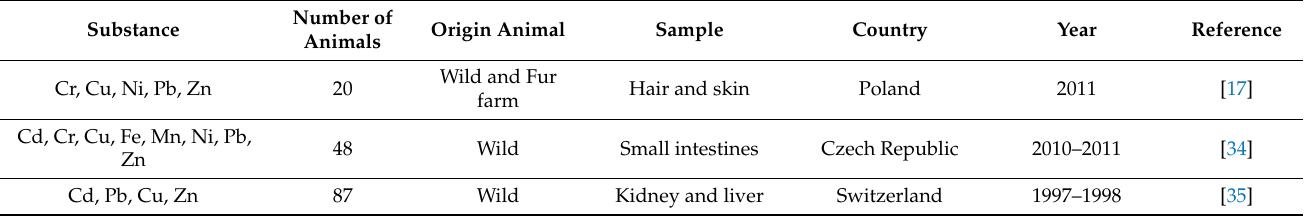
Table 1. Review of articles that evaluated environmental contaminates in red fox ( Vulpes vulpes ) regarding the number of animals substance type, year, sample type analyzed, country, the origin of the animals (wild or fur